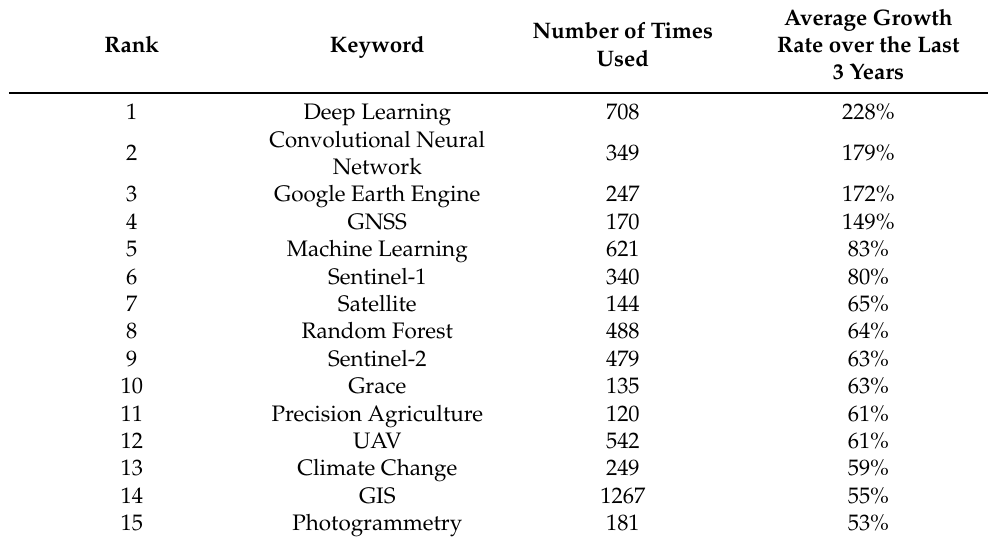
Table 4. Number of times that keywords are used in articles published in Remote Sensing and average growth rate for the last three years sorted by the average growth